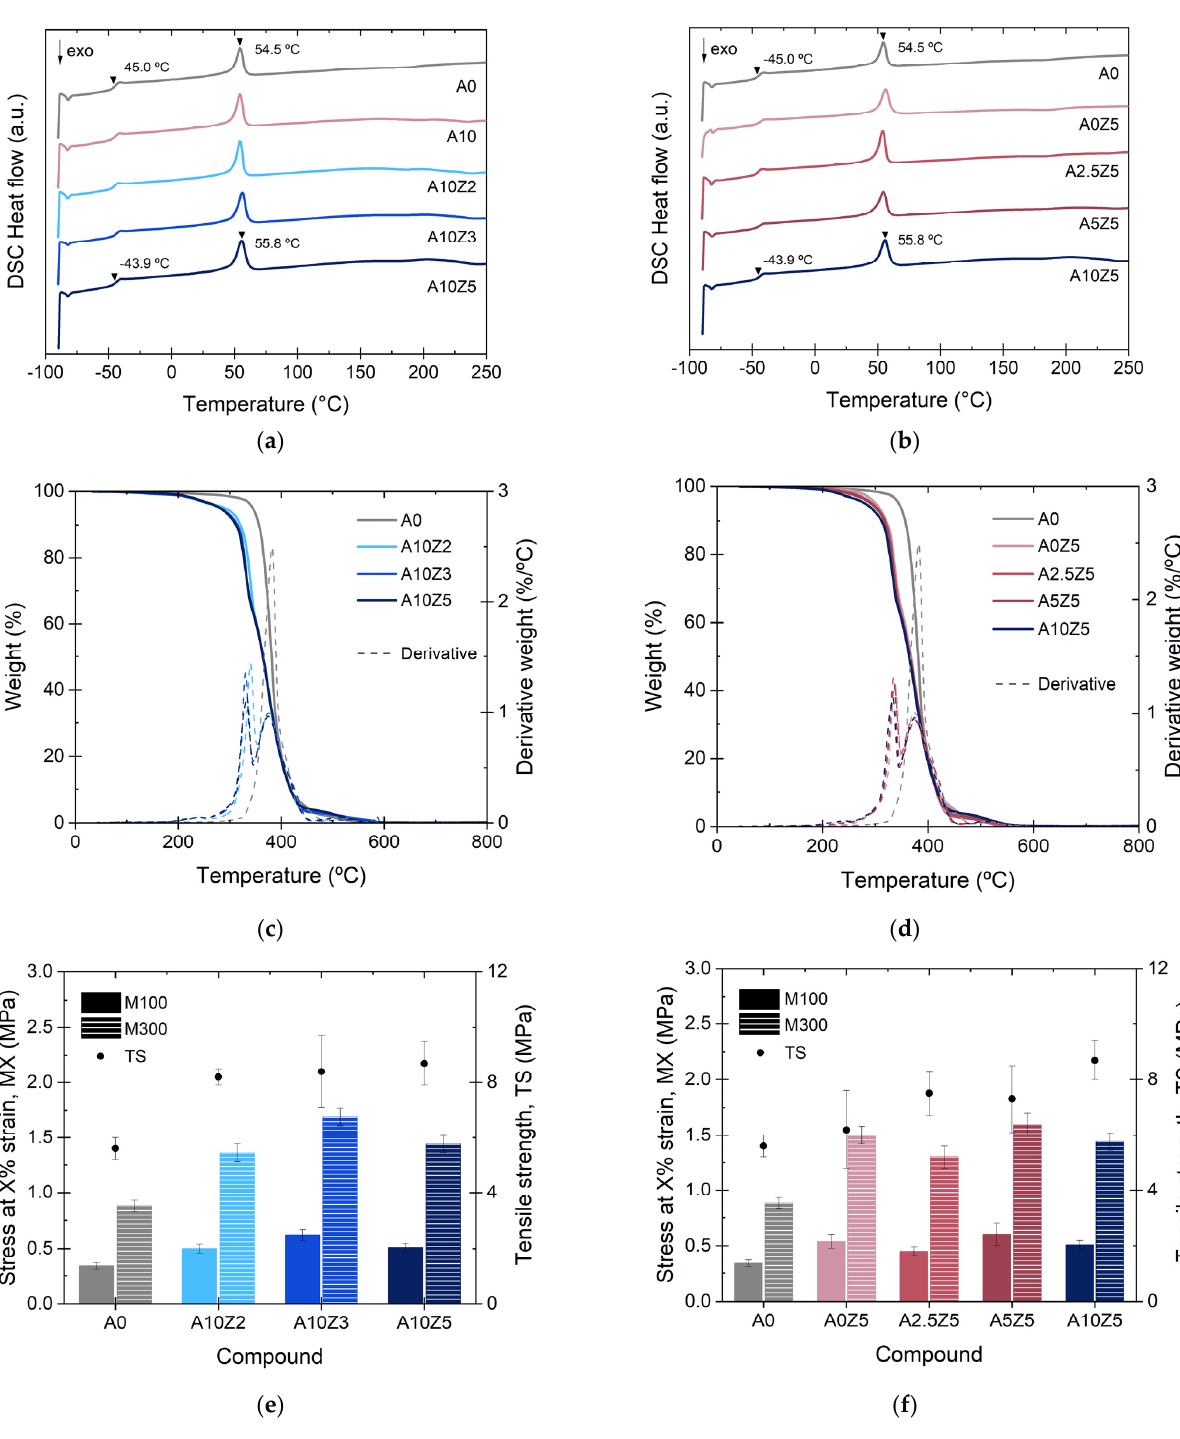
Figure 8. ( a , b ) DSC thermograms, ( c , d ) thermogravimetric curves, and ( e , f ) tensile properties of TPEs reinforced with A and ZnO.